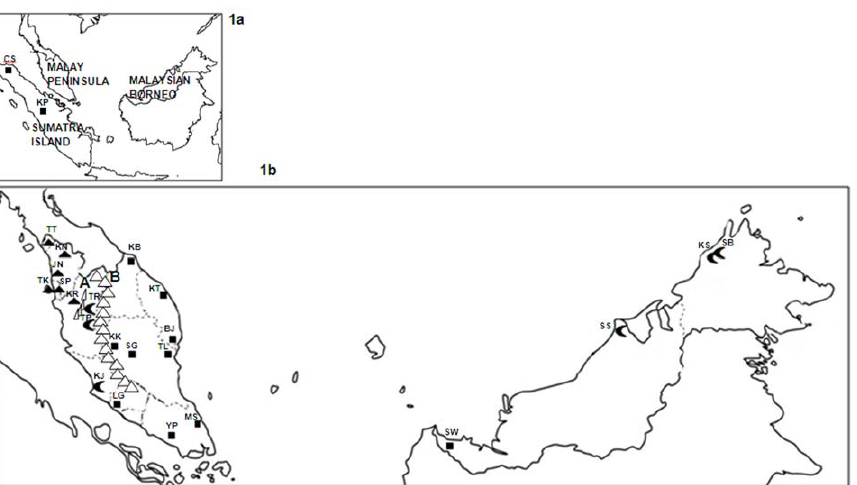
Figure 1. Channastriata locality distribution. 1a) Map showing isolated regions involved in this study. 1b) Clustering of C. striata populations based on SAMOVA analysis indicated by different symbols: group 1 (triangles), group 2 (new moon) and group 3 (square). A indicates Bintang Mountain Range, B indicates Titiwangsa Montain Ranges. Population abbr.: TT-Timah Tasoh KN-Kuala Nerang JN-Jeniang SP-Seberang Prai TK-Teluk Kumbar KR-Kerian TR-Tanjung Rambutan TP-Tapah KJ-Kajang LG-Linggi YP-Yong Peng MS-Mersing KB-Kota Bahru BJ-Binjai KT-Kubang Bujuk KK- Kuala Krau SG-Sega TL-Tanjung Lumpur SB-Kota Belud KS-Kampung Kesapang SS-Sungai Sibuti SW-Serian CS-Takengon KP-Kampar.